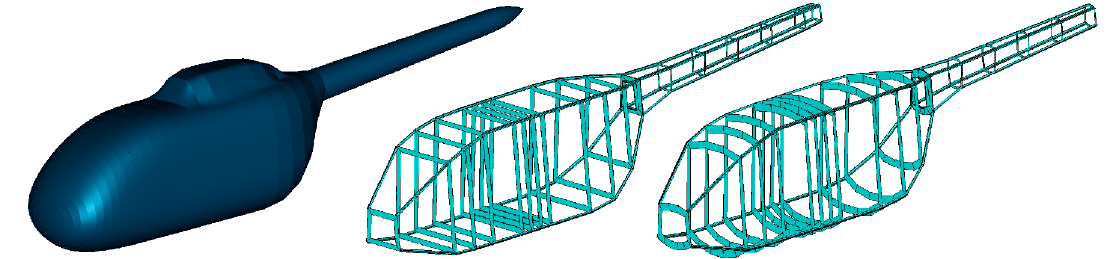
Figure 20. Influence of the amount of interpolation points on the model accuracy.